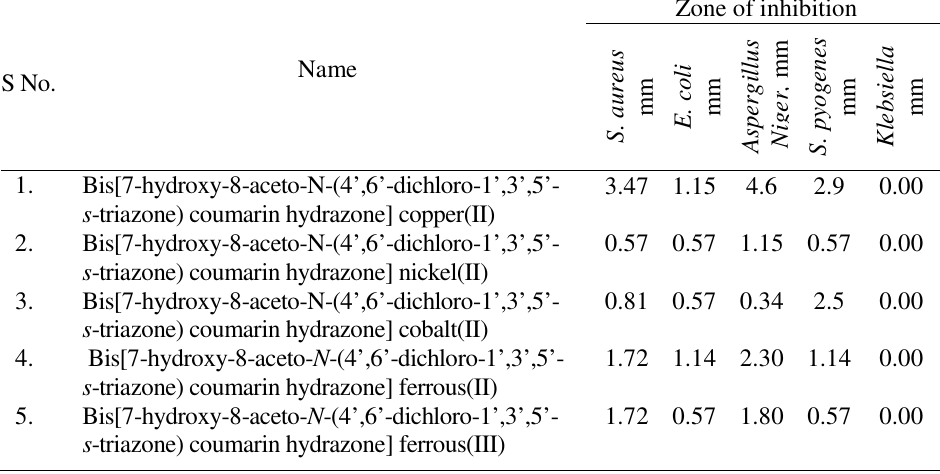
Table 2. Antimicrobial activity of compounds.